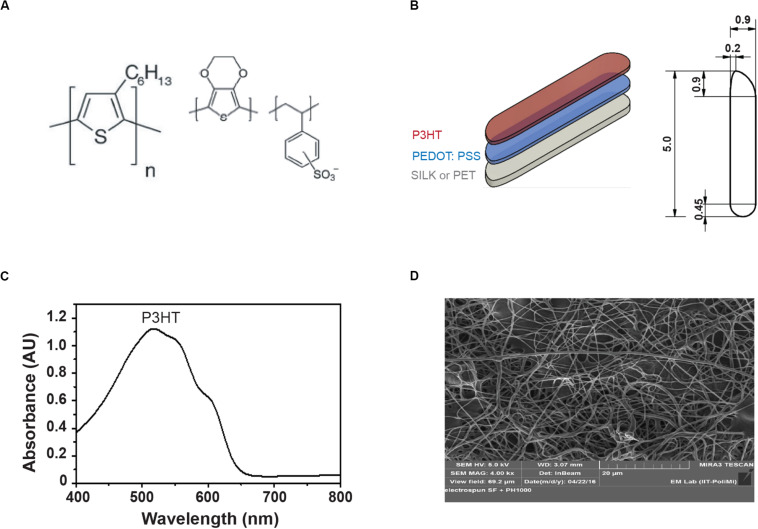
Characterization of the polymeric prosthesis. (A) Structural formulas of the two polymeric components of the prosthetic device, the semiconductive P3HT (left) and the organic conductor PEDOT:PSS (right). (B) The figure depicts the layer composition and the dimensions (mm) of the prosthesis designed for the pig’s eye. (C) Absorbance spectrum of the P3HT layer in the prosthesis shows its activation profile extending to the majority of the visible spectrum. (D) SEM image of the filamentous ultrastructure of the ESF substrate (magnification, 4000x; view field, 69.2 μm).